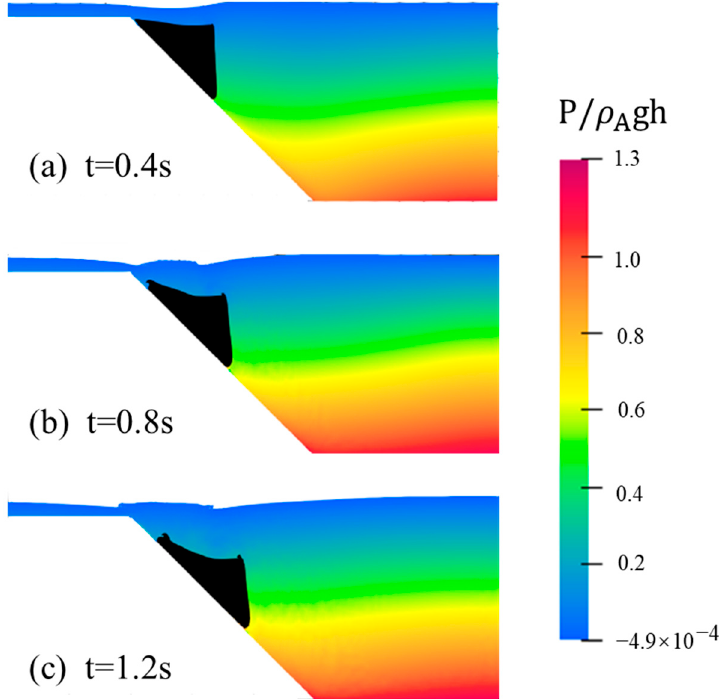
Figure 15. Snapshots of the pressure field at typical instants. ( a ) pressure field at t = 0.4 s; ( b ) pressure field at t = 0.8 s; ( c ) pressure field at t = 1.2 s.